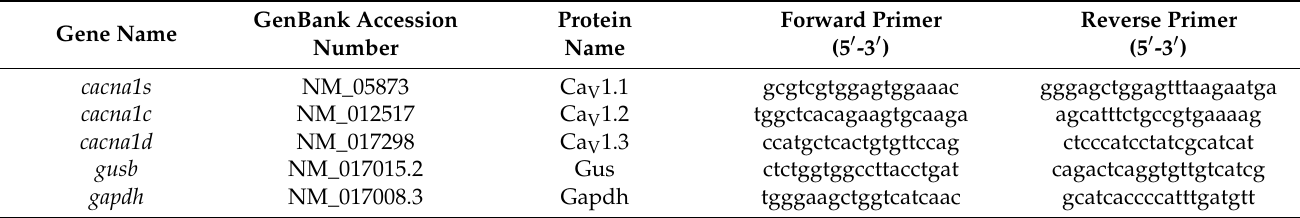
Table 2. Primer pairs used to amplify LTCC transcripts by